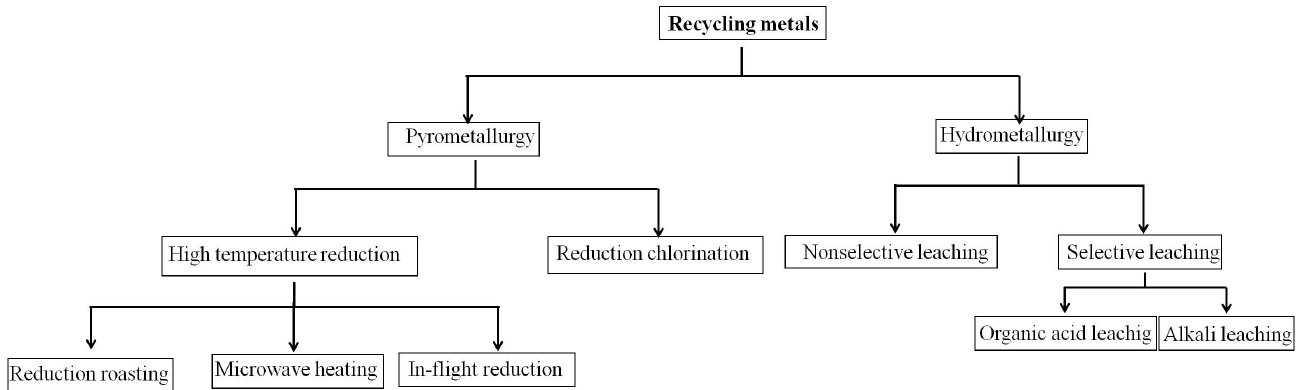
Figure 2. Graphic illustration of the methods for recovering metal from dust.